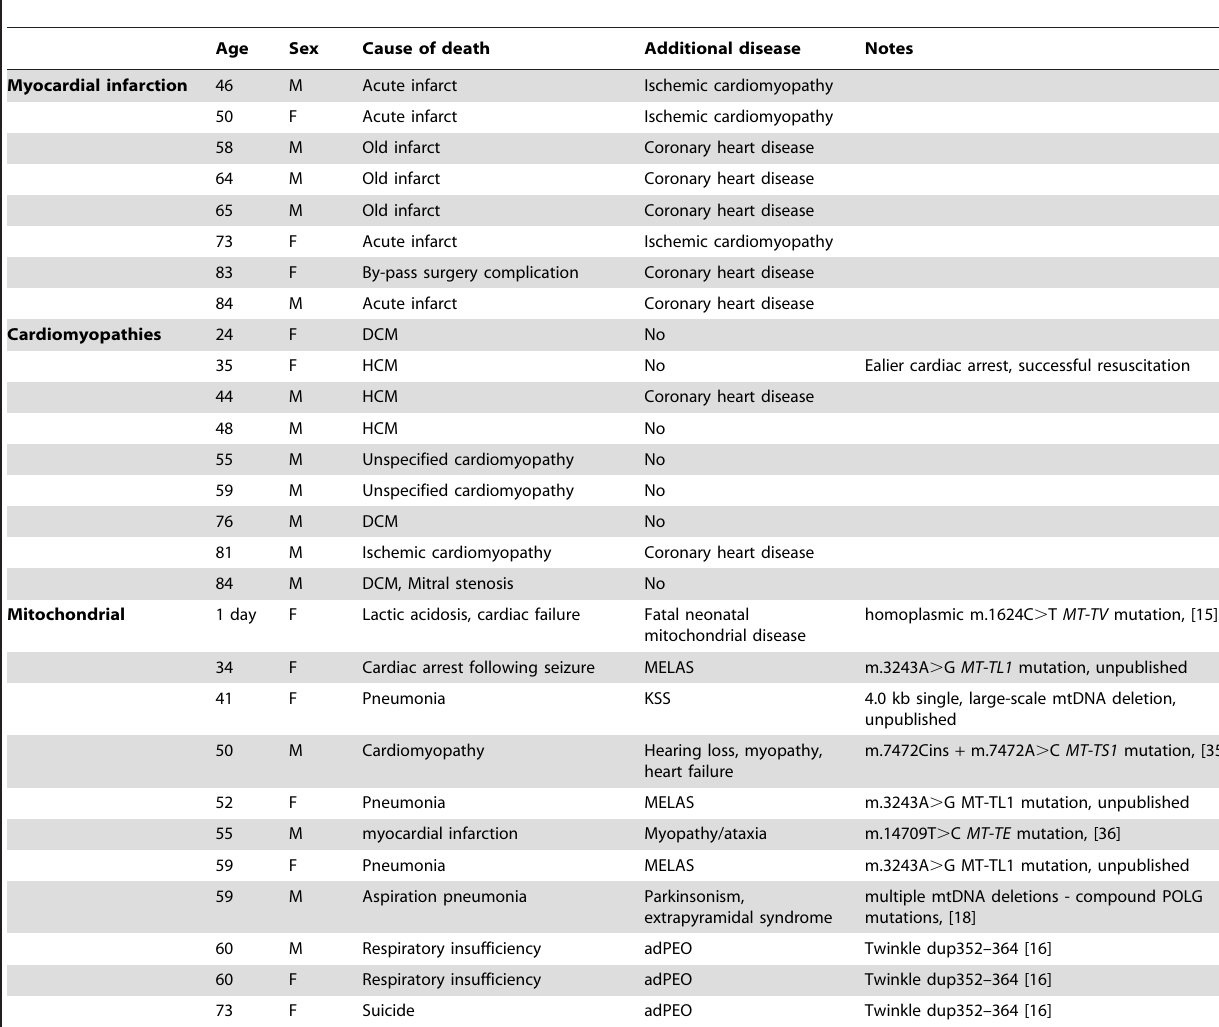
Table 2. Details of the left ventricular heart muscle samples of individuals with a fatal diagnosed heart disease or a mitochondrial